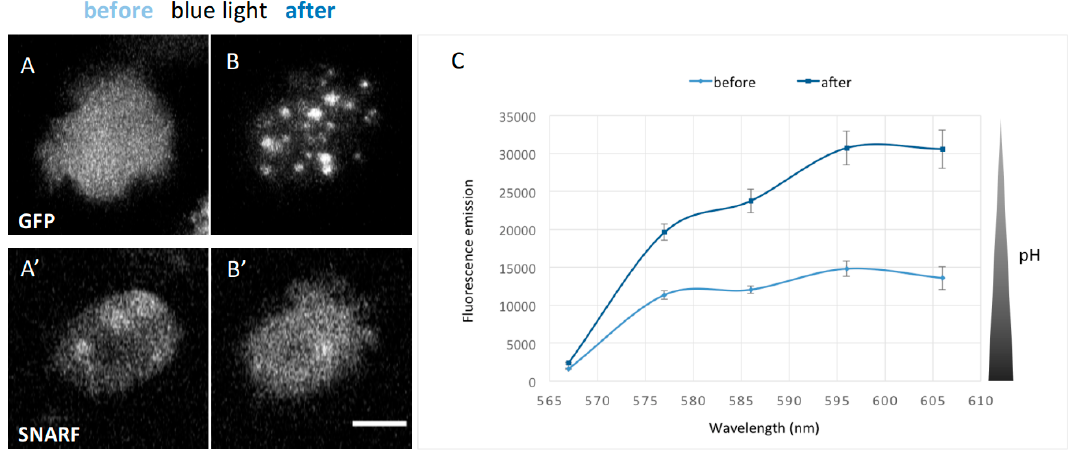
Figure 5. GFP-NE81-S122E ∆ NLS ∆ CLIM cells show a decrease in intracellular pH after excitation with blue light and form reversible cytosolic protein clusters. Live cells were loaded with the SNARF pH sensor. Blue light stimulation occurred for 30 s with a mercury halide lamp at a laser scanning confocal microscope (see methods): ( A , A’ ) cells prior to blue light stimulation; and ( B , B’ ) after blue light stimulation. The recombinant protein forms assemblies while SNARF fluorescence increases. Scale bar = 5 µ m. ( C ) Emission spectra of SNARF-loaded GFP-NE81-S122E ∆ NLS ∆ CLIM cells ( n = 8) excited at 561 nm and measured 3 min after blue light stimulation. The fluorescence emission of SNARF strongly increased between 565 and 610 nm.